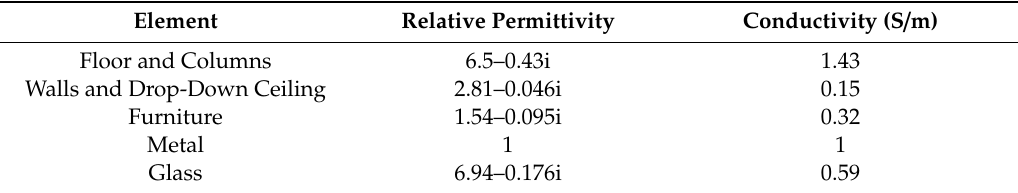
Table 1. Values of relative permittivity and conductivity of materials.